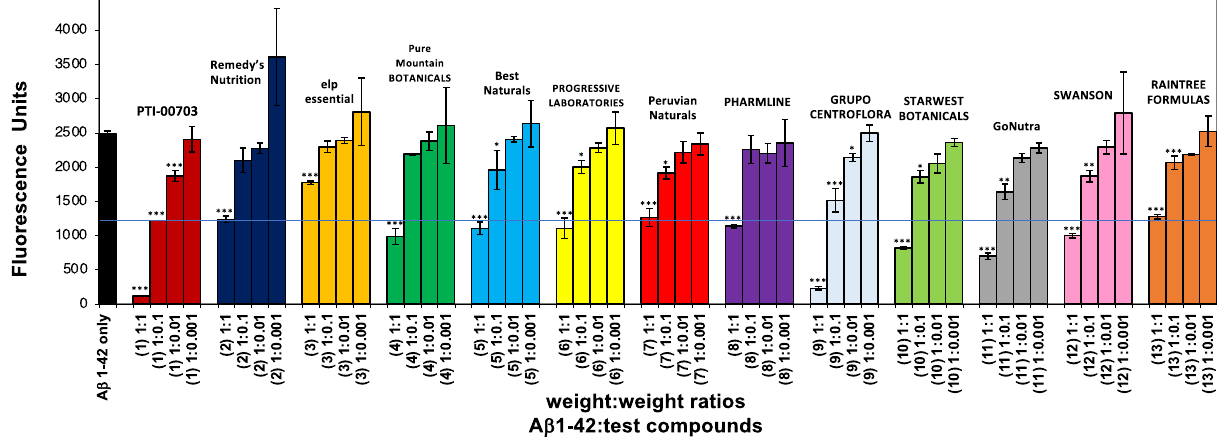
Figure 9. Identification of PTI-00703 Cat’s claw ( Uncaria tomentosa ) as the most potent disrupter of Aβ 1–42 fibrils in comparison to other cat’s claw sources in the marketplace today. PTI-00703 Cat’s claw compared to 12 other cat’s claw sources for its ability to disrupt/dissolve pre-formed Aβ 1–42 fibrils. This included cat’s claw from Remedy’s Nutrition, elp essential, Pure Mountain BOTANICALS, Best Naturals, PROGRESSIVE LABORATORIES, Peruvian Naturals, PHARMLINE, GRUPO CENTROFLORA, STARWEST BOTANICALS, GoNutra, SWANSON, and RAINTREE FORMULAS. PTI-00703 Cat’s claw demonstrated a